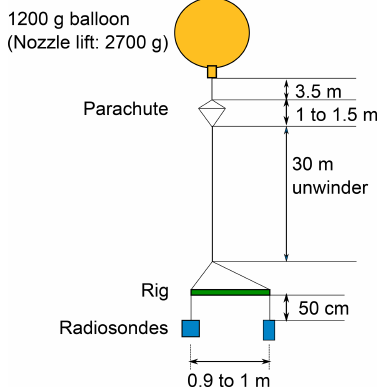
Figure 9. Payload configurations for dual